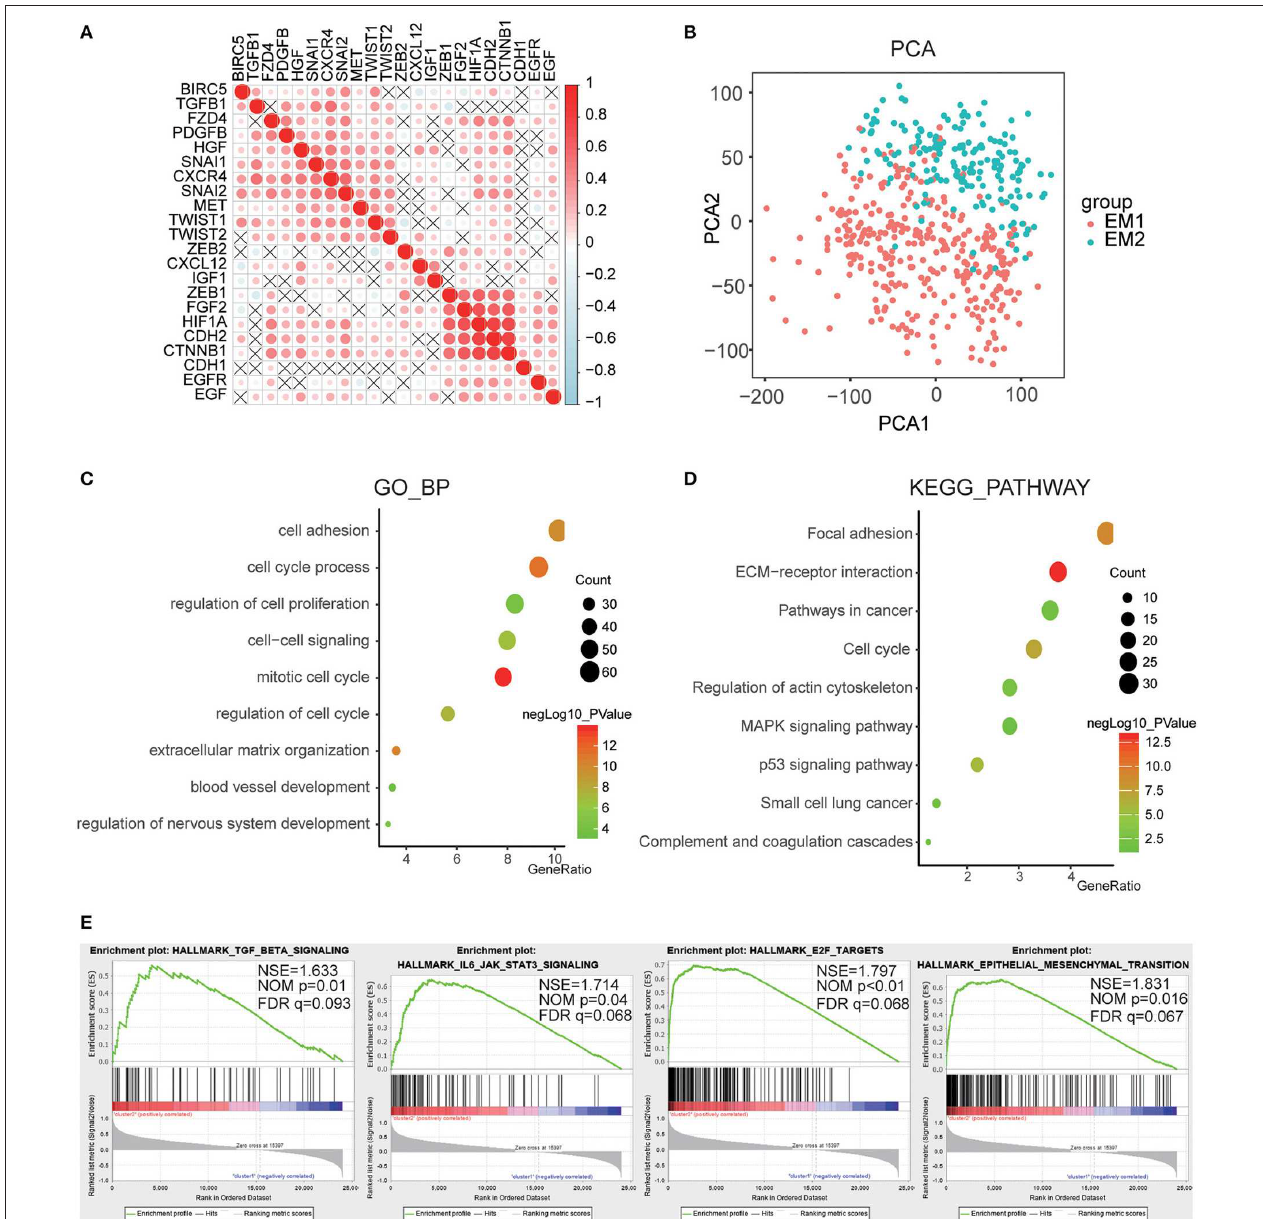
FIGURE 5 | Interaction among EMT related genes and functional annotation of gliomas in EM1/2 subgroups. (A) Spearman correlation analysis of the 22 EMT related genes. (B) Principal component analysis of the total RNA expression profile in the CGGA dataset. (C,D) Functional annotation of the genes with different expression between two subgroups using GO terms of biological processes (C) and KEGG pathway (D) . (E) GSEA is used to annotate the malignant hallmarks of these genes with different expression levels between the two